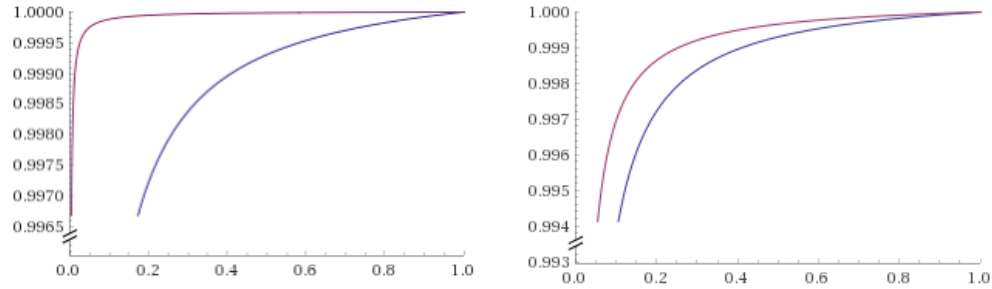
Figure 4. This figure shows the conditional probability P ( DR in Table 1. X-axis represents P ( DR ) and Y-axis P ( DR embodying an exponential likelihood for DR , is pictured against P ( DR cub by using a cubic likelihood. On the right panel, P ( DR exp P ( DR lin data ) (violet line), computed with a linear |